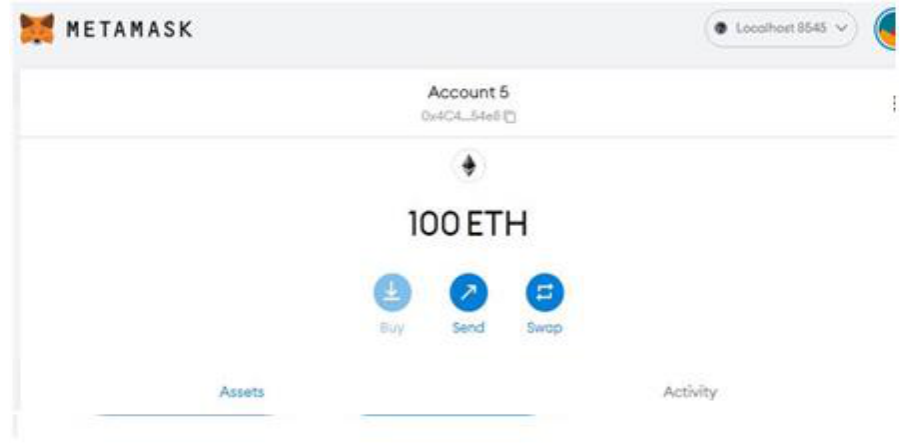
Figure 9. Metamask account with 100ETH.